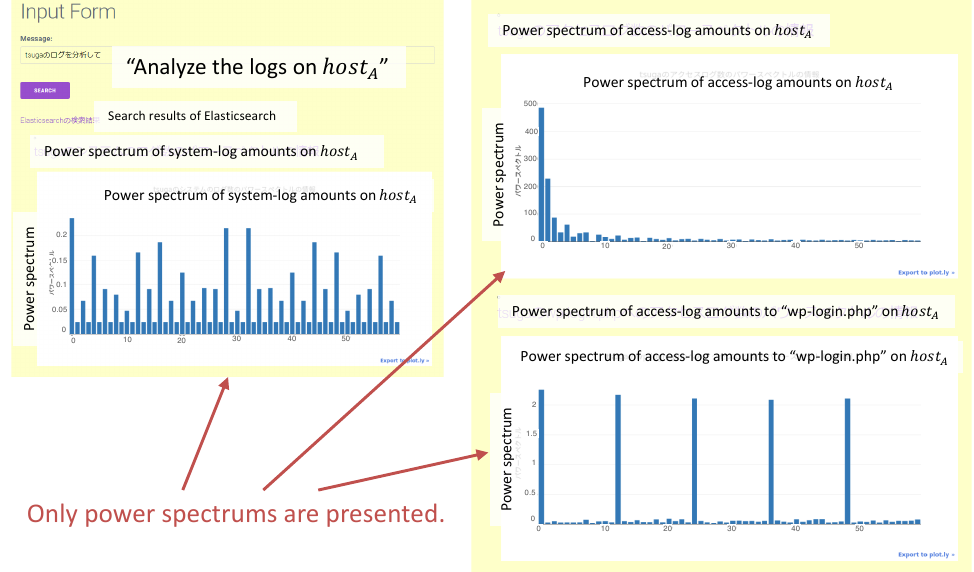
Figure 18. Example of the undesirable output. In this case, the request “Analyze the logs of host A .” was input. The system output only the power spectrums of the logs, but it was not a high-priority analysis for the target